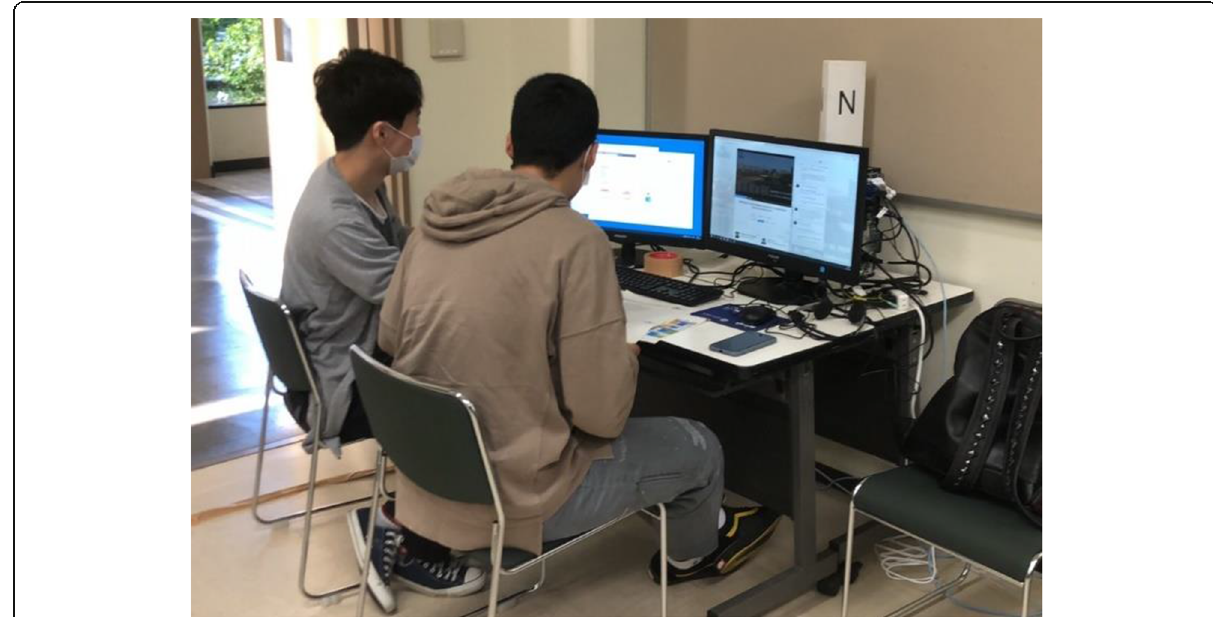
Fig. 3 Students at Kanazawa University serving as a “ support center